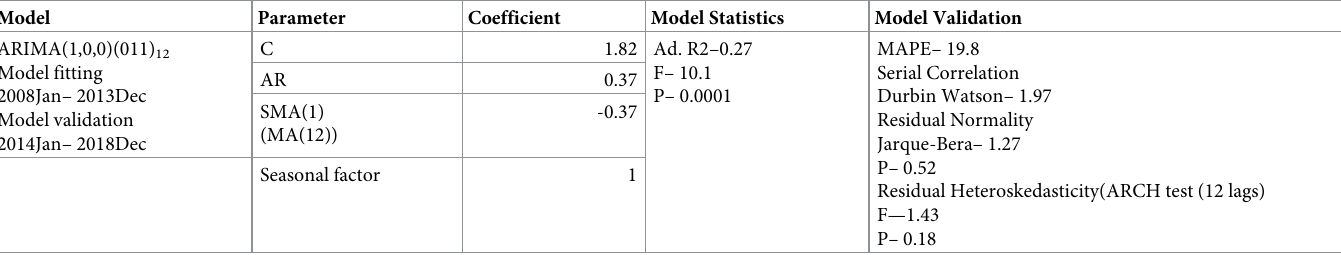
Table 3. Model description of best fitted, univariate seasonal ARIMA model for the monthly leptospirosis cases of Anuradhapura District, Sri Lanka.